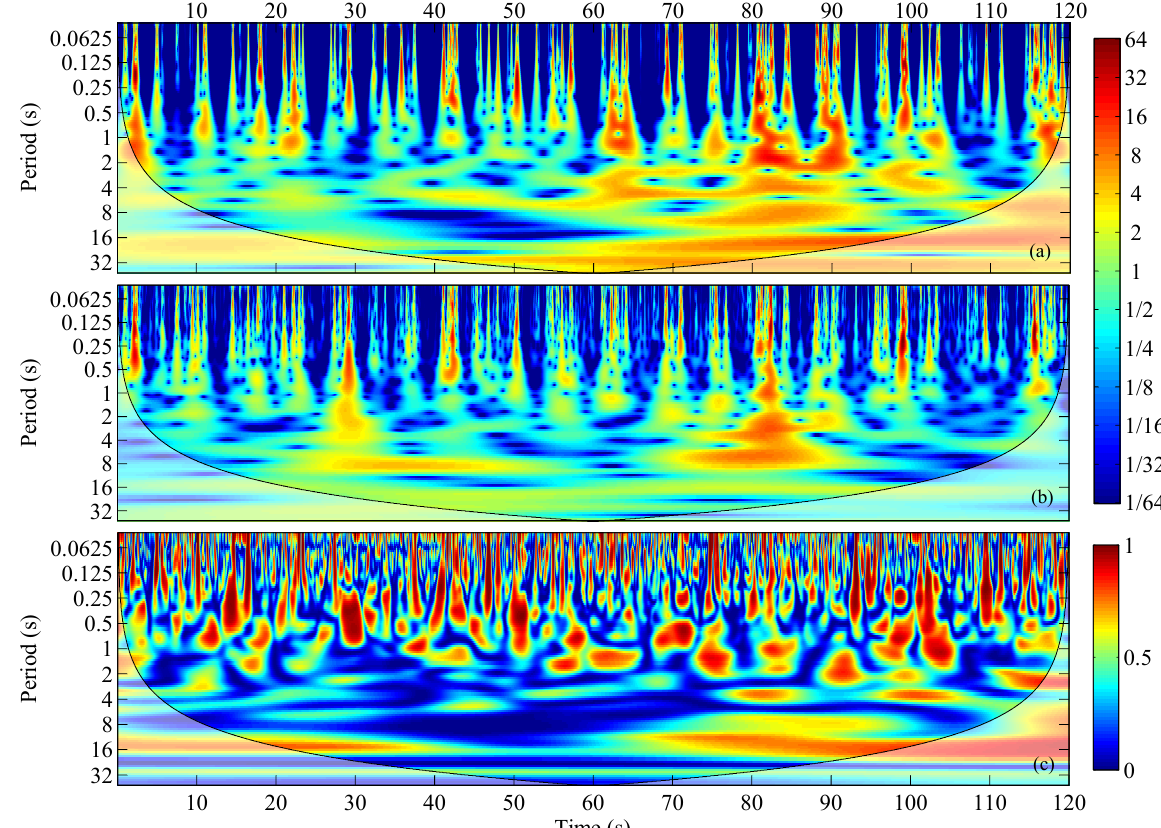
Figure 10. Wavelet power spectra (Morlet wavelet) for below the measured mean critical velocity experiment ( u < u cr,measured ) for a 2min period showing the (a) momentum flux ( u (cid:48) ,w (cid:48) ), (b) sediment flux ( c (cid:48) ,w (cid:48) ), and (c) coherence between the momentum and sediment fluxes. 0.050.35 Figure 11. Schematic diagram showing the measured and calculated mean critical velocities.